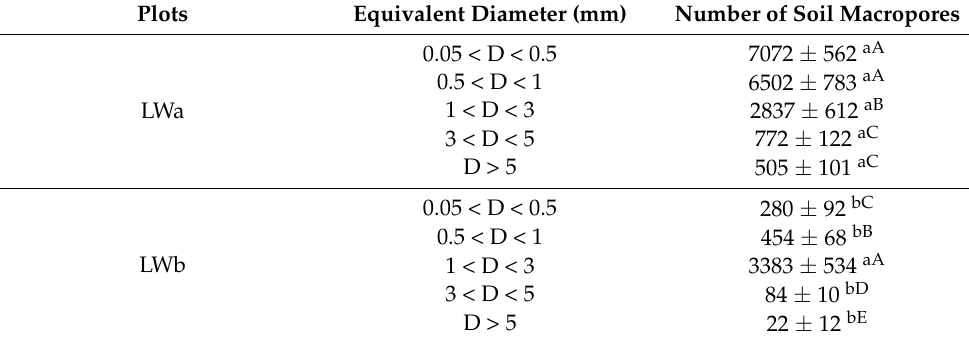
Table 2. Number of soil macropores in entire soil columns at LWa and LWb. Plots